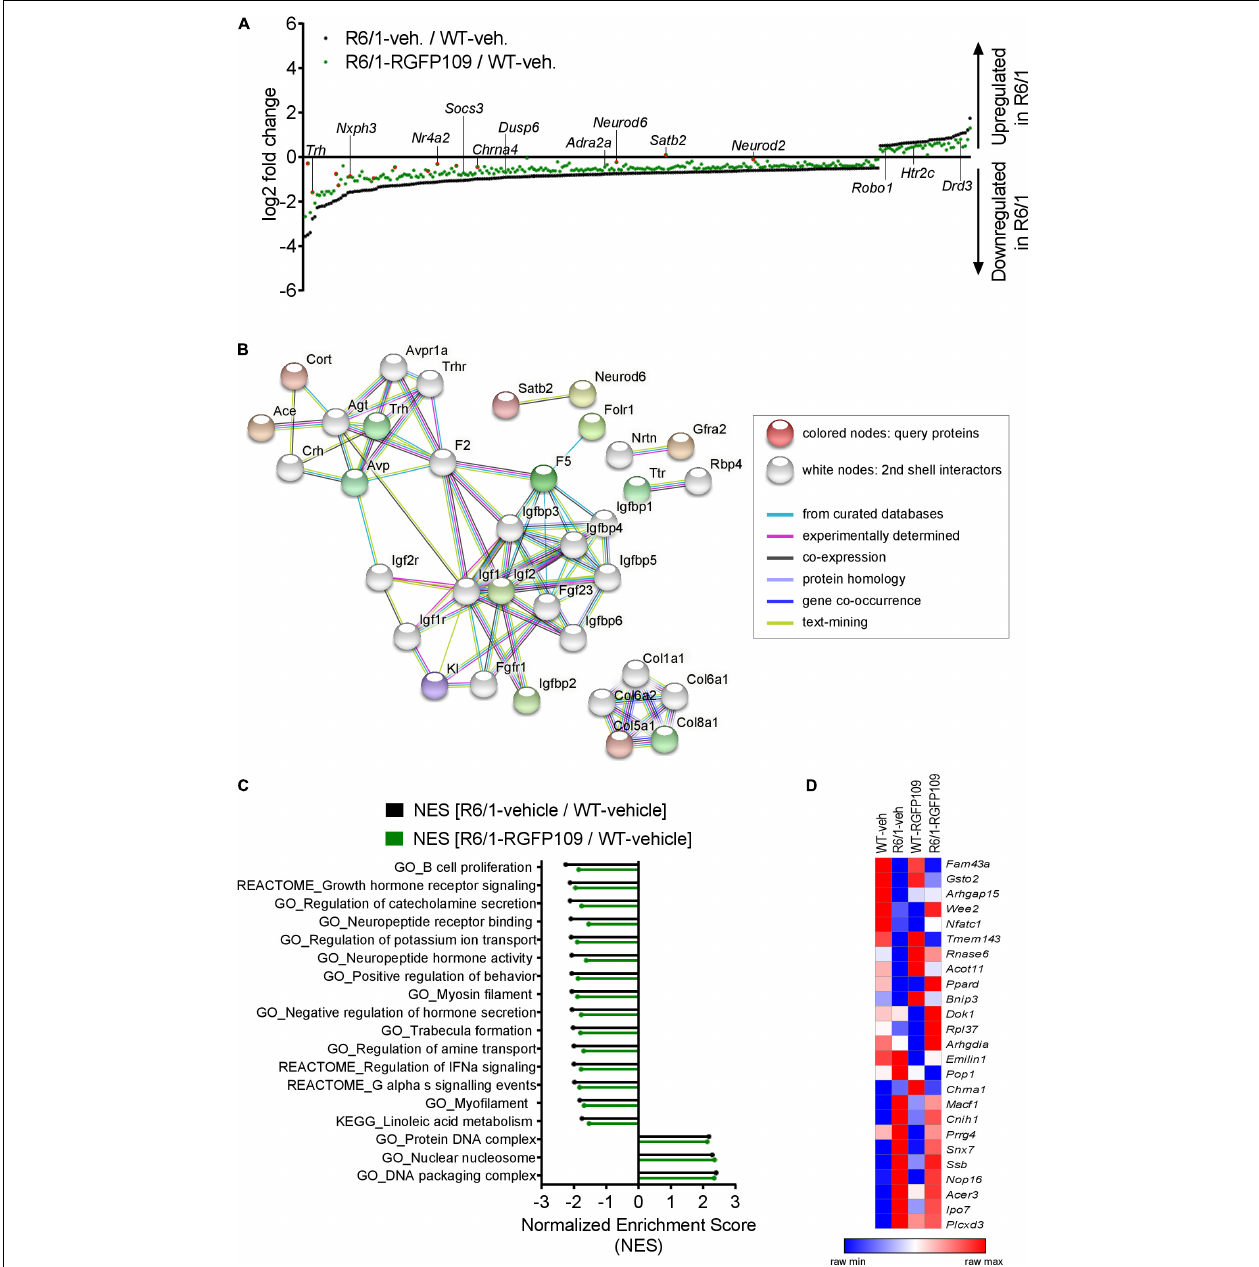
FIGURE 2 | Inhibition of HDAC1 and HDAC3 by RGFP109 has a partial repair effect on global gene expression changes in the striatum of R6/1 mice. (A) 283 genes, significantly differentially expressed between WT and R6/1 mice (black) ( Cuffdiff 2 ; FDR, q < 0.1; log2 FC > | 0.5|), are changed toward wild type expression levels in RGFP109-treated R6/1 animals by at least 20% using no cutoff criteria on the data for statistical significance (green). Significantly differentially expressed genes upon RGFP109 treatment in R6/1 mice (R6/1-RGFP109/R6/1-vehicle; FDR, q < 0.1; log2 FC > | 0.5|) are framed in red. Selected genes are labeled. (B) STRING protein-protein interaction network analysis. Forty three genes differentially expressed between R6/1-vehicle and R6/1-RGFP109 (FDR, q < 0.1; log2 FC > | 0.5|) were used as input and assigned to proteins (query proteins). The maximum number of 2nd shell interactors was set to 20. Network nodes represent proteins. Edges represent protein-protein associations. Disconnected nodes in the network are hidden. (C) Gene set enrichment analysis (GSEA—Broad Institute) for gene ontology, KEGG pathway, and REACTOME pathway gene sets. Genes were ranked based on log2 fold changes. The bar graph shows gene sets with significant different normalized enrichment scores (NES) between WT-vehicle and R6/1-vehicle mice (FDR, q < 0.1). NESs of RGFP109-treated R6/1 compared to WT-vehicle mice are plotted for the same gene sets. Gene sets with positive NES and the top 15 gene sets with highest difference between both comparisons for negative NES are plotted. (D) Heatmap for gene expression levels of 25 genes, that show a change toward wild type levels by RGFP109 treatment in R6/1 mice, from a list of genes whose expression were restored by HDACi treatment in a previous study (Thomas et al., 2008). Mean FPKM value/group is shown. Each row is a gene and each column is a group. n = 5 [WT-vehicle], n = 6 [R6/1-vehicle], n = 7